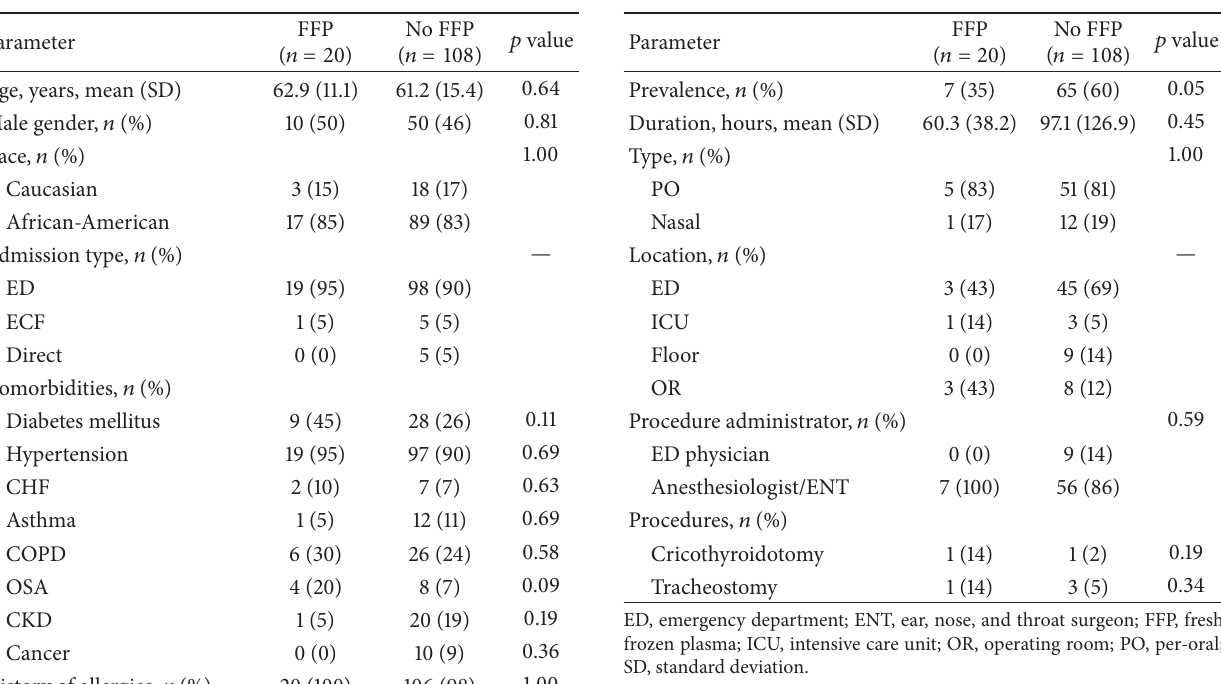
Table 1: Patient characteristics. Table 2: Intubation